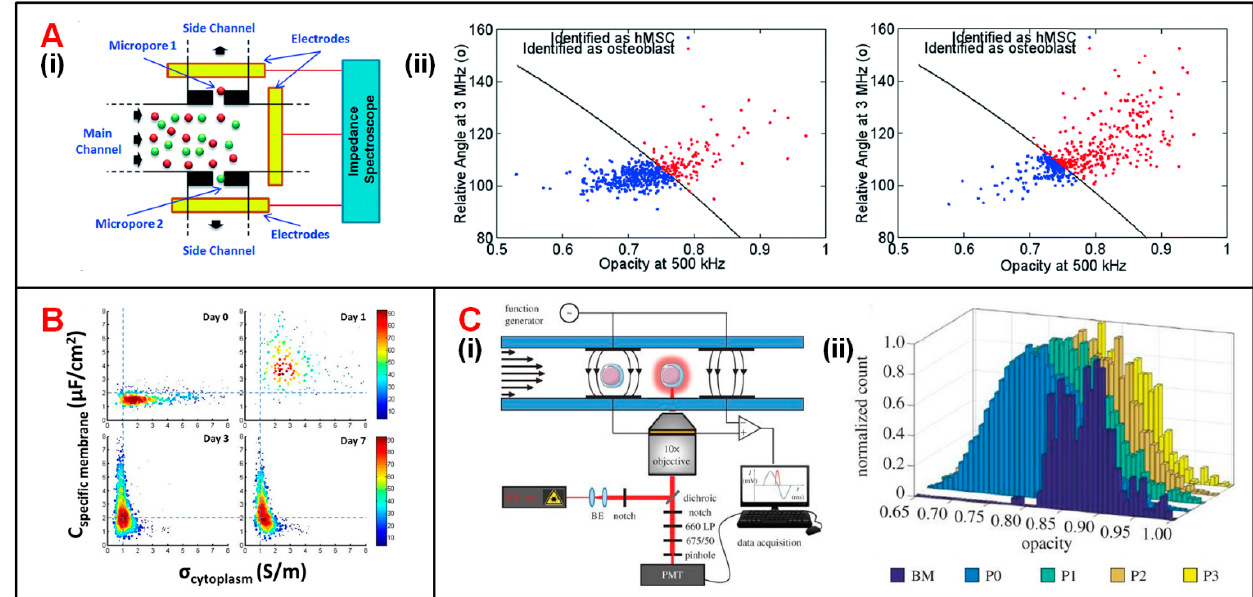
Figure 6. Stem cell analysis using IFC devices. ( A ) ( i ) Schematics of a dual-micropore based IFC device consisting of a main channel and two deputy channels through micropores. ( ii ) Scatter plot of signal phase at 3 MHz vs. opacity (|Z 3MHz |/|Z 500kHz |) for hMSCs and osteoblasts at 7 days (on the left) and 14 days (on the right) after post-induction. Reproduced from [125] with the permission from Royal Society of Chemistry. ( B ) C specific membrane and σ cytoplasm variations of rat neural stem cells within the differentiation process of 7 days. Reproduced from [126] with the permission from Public Library of Science. ( C ) ( i ) Schematics of an IFC device integrated fluorescence detection. ( ii ) Changes of impedance signal opacity (|Z 2MHz |/|Z 500kHz |) within 56 days SSCs differentiation process. Reproduced from [127] with the permission from Royal